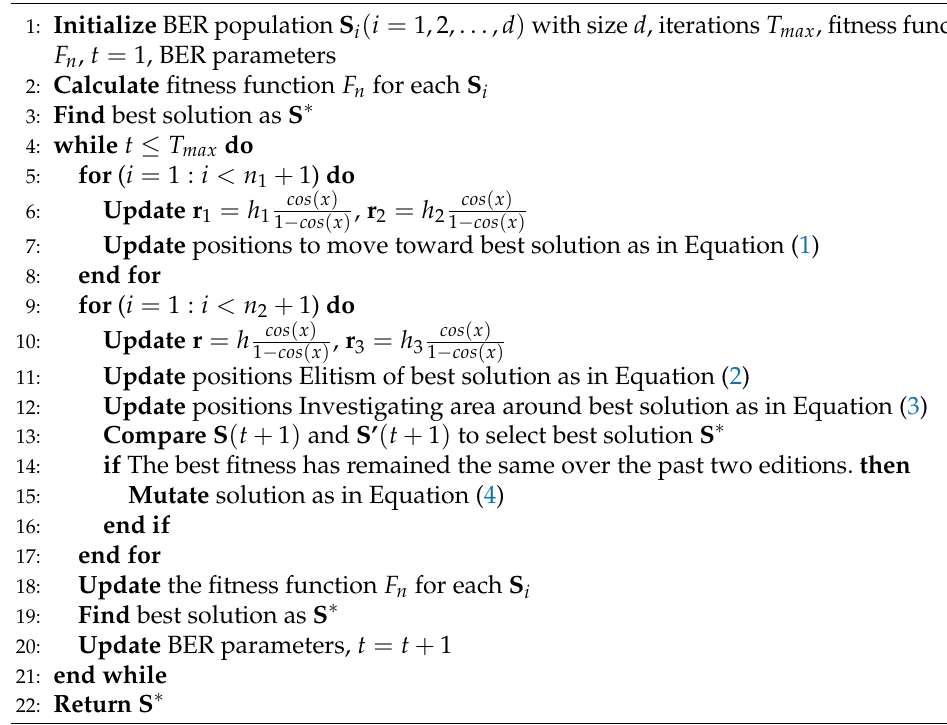
Algorithm 1 AL-Biruni Earth radius (BER)